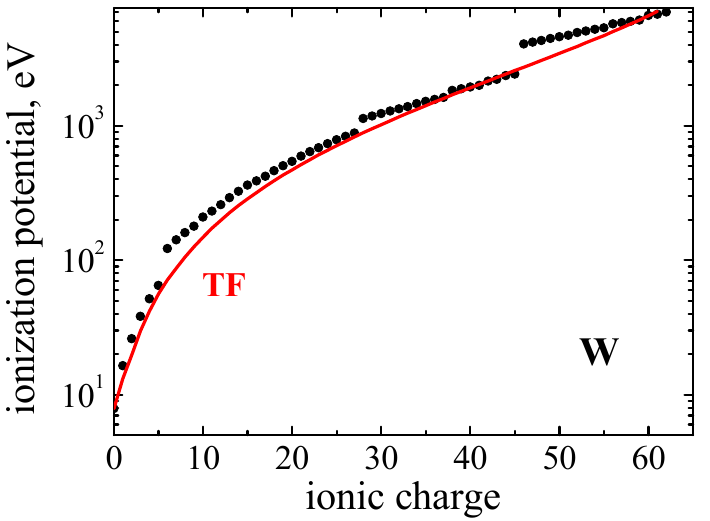
Figure 3. Ionization potentials of W ions: solid lines—approximation in Thomas-Fermi model (TF); points—tabulated ionization potentials of W